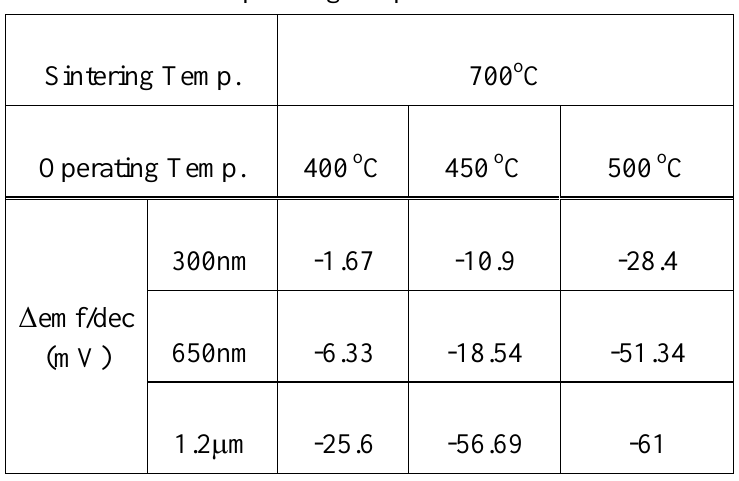
Table.1. ∆ EMF/dec values for the sensors of various electrolyte thicknesses at different sintering and operating